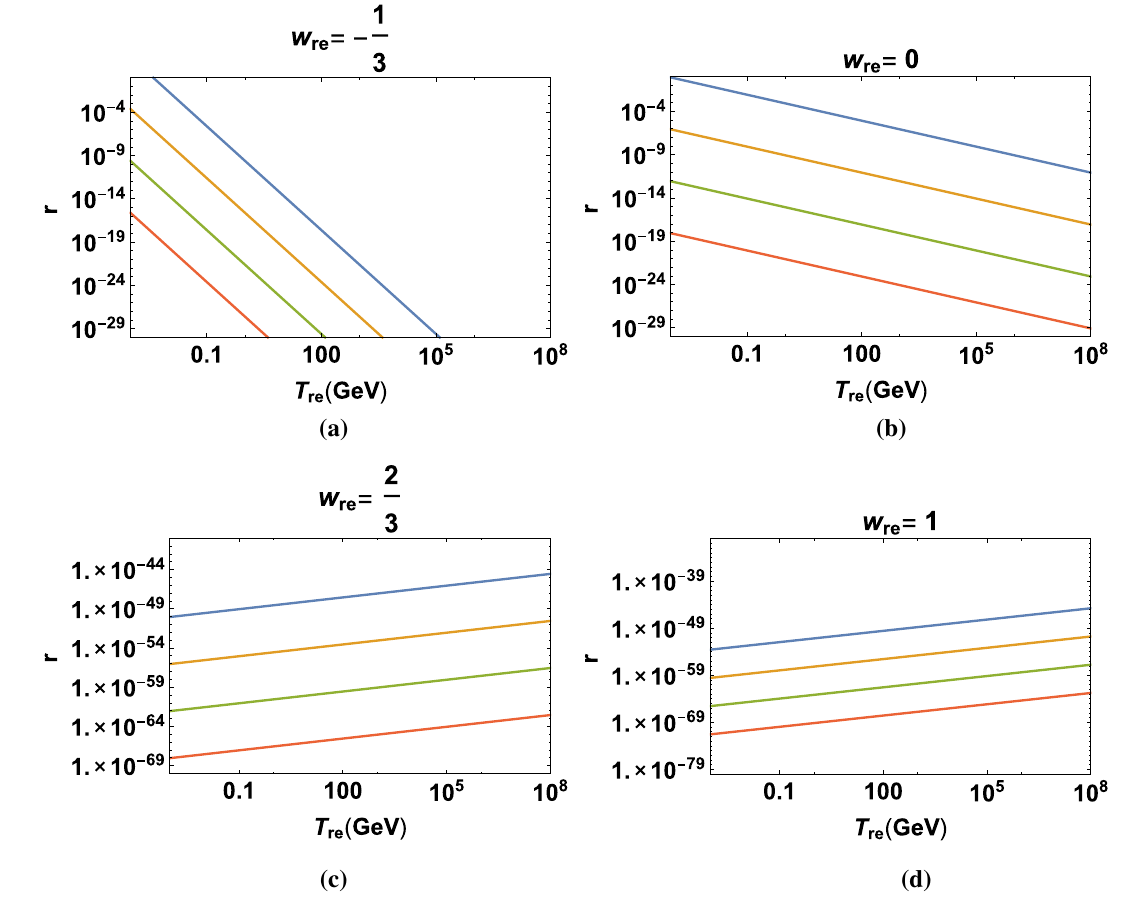
Fig. 7 Plots of r versus T re for some given values of M 5 allowed in the range following [67] with w re fixed in each case. The red, green, yellow and blue lines corresponds to M 5 = 10 17 , 10 16 , 10 15 , 10 14 GeV